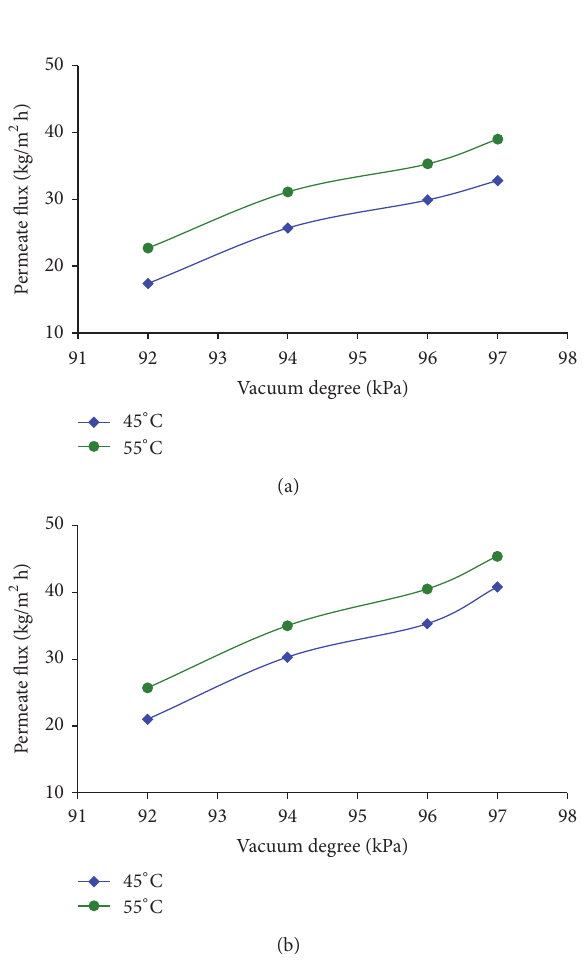
Figure 11: The effect of the vacuum degree on the permeate flux at 45 and 55 ∘ C feed temperatures; 110.2(L/h) feed flow rate and 35,000 mg/L of NaCl for (a) PVDF and (b) PTFE